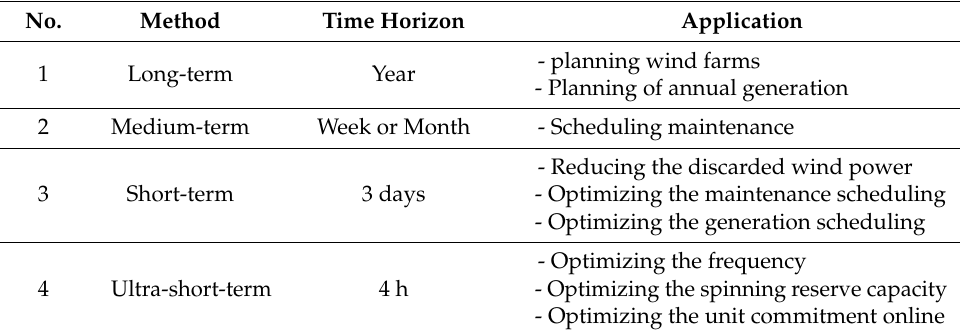
Table 1. Classification of wind power prediction based on time